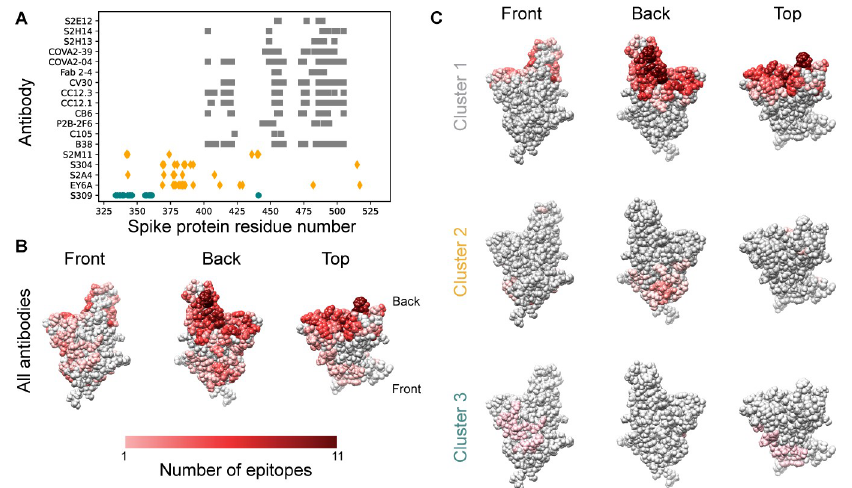
Fig 1. Epitopes for antibodies targeting the spike protein RBD overlap substantially. A. Contact residues for spike protein RBD antibody epitopes. Colors and symbols denote antibody clusters: Grey squares: Cluster 1, yellow diamonds: Cluster 2, green circles: Cluster 3. B. RBD structure with each residue colored by the number of antibody epitopes including it, compiled from PDB data. C. RBD structure, colored by the number of antibody epitopes that each residue is part of, by epitope